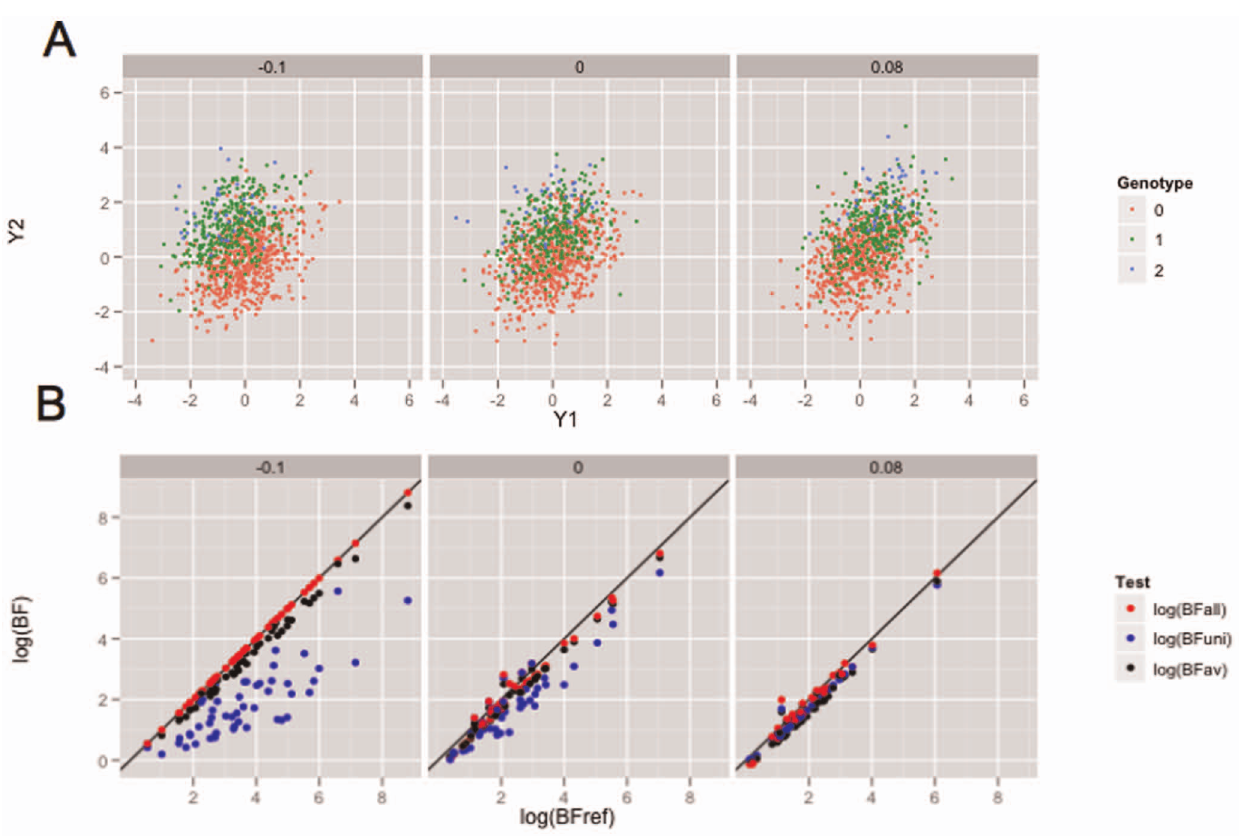
Figure 3. Comparison of Bayes Factors in simple bivariate simulations, correlation =0.4. The upper panel shows a typical simulated dataset under each of three scenarios (see text), but with effect sizes increased | 5 to aid clarity; each dot represents a single individual, colored according to genotype. Note that in the middle scenario only Y 2 is associated with genotype. The lower panel compares BF all ,BF uni and BF av with a reference BF, which is the theoretical optimal for that simulation scenario. Thus one can see not only how the BFs compare with each other, but also the extent to which they lose compared with the optimal. Each point represents the results from a single simulation, and each simulation is represented by three points.